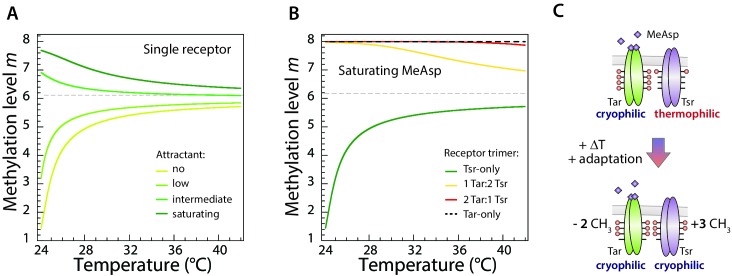
Average modeled methylation levels of receptors versus temperature for different concentrations of chemical attractant.(A) Modeled adapted methylation levels of trimers of a single receptor type (Tar). Modeling was done using the same parameters as in Figure 4A, in the absence of attractant or at low, intermediate, and saturating attractant (MeAsp) concentrations, as indicated. As temperature increases, for all attractant concentrations, the per-receptor methylation level approaches the same asymptotic value, never crossing it. Thus the sign of the thermal response remains constant, implying the cell is either always cold seeking or always heat seeking, depending on the initial value of methylation. (B) Modeled methylation levels of different mixed-receptor trimers present in cells that display an accumulation temperature. With imperfect adaptation, the thermal response of mixed-receptor cells may change sign with temperature, giving rise to an accumulation temperature (dark green curve in Figure 4B). We plot the methylation levels of the four possible trimers (each consisting of 3 receptors): Tsr-only (green), 1Tar:2Tsr (yellow), 2Tar:1Tsr (red), and Tar-only (dashed black). Here Tar is stimulated with saturating level of MeAsp while Tsr remains unstimulated, with the same parameters as for the dark green curve in Figure 4B. At low temperature, the response is dominated by the heat-seeking Tsr-only trimer. As temperature is increased, its methylation level approaches the asymptotic high-temperature methylation level, and its response become weaker. On the other hand, the responses of the trimers that include stimulated Tar receptors only change slightly, as their methylation levels remain close to saturation, due to the slowing down of methylation in that regime. Eventually the response of these cold-seeking trimers overcomes that of the Tsr-only trimer, and the thermotactic response changes sign. (C) Schematic illustration of the change in methylation of Tar and Tsr dimers due to increase in temperature, in the presence of a high concentration of MeAsp. The methylated sites are highlighted as red circles. When methylation of Tar is close to saturation, Tar cannot adapt perfectly, meaning that upon temperature stimulation the methylation level of Tar changes less than the opposite methylation of Tsr (illustrated as different numbers of added/removed CH3 groups). This difference allows a net change in total receptor methylation and thus the change in the sign of the overall thermotactic response.